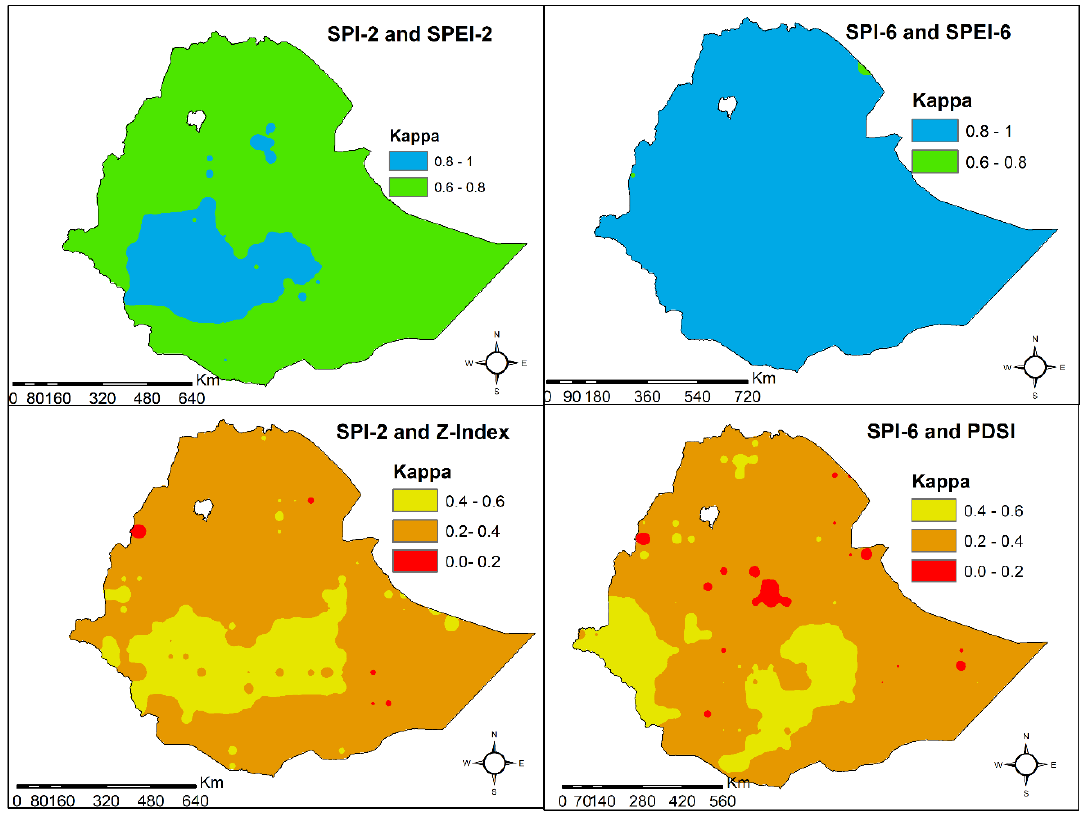
Figure 5. Cohen kappa values across Ethiopia for agricultural and meteorological drought indicator combinations.